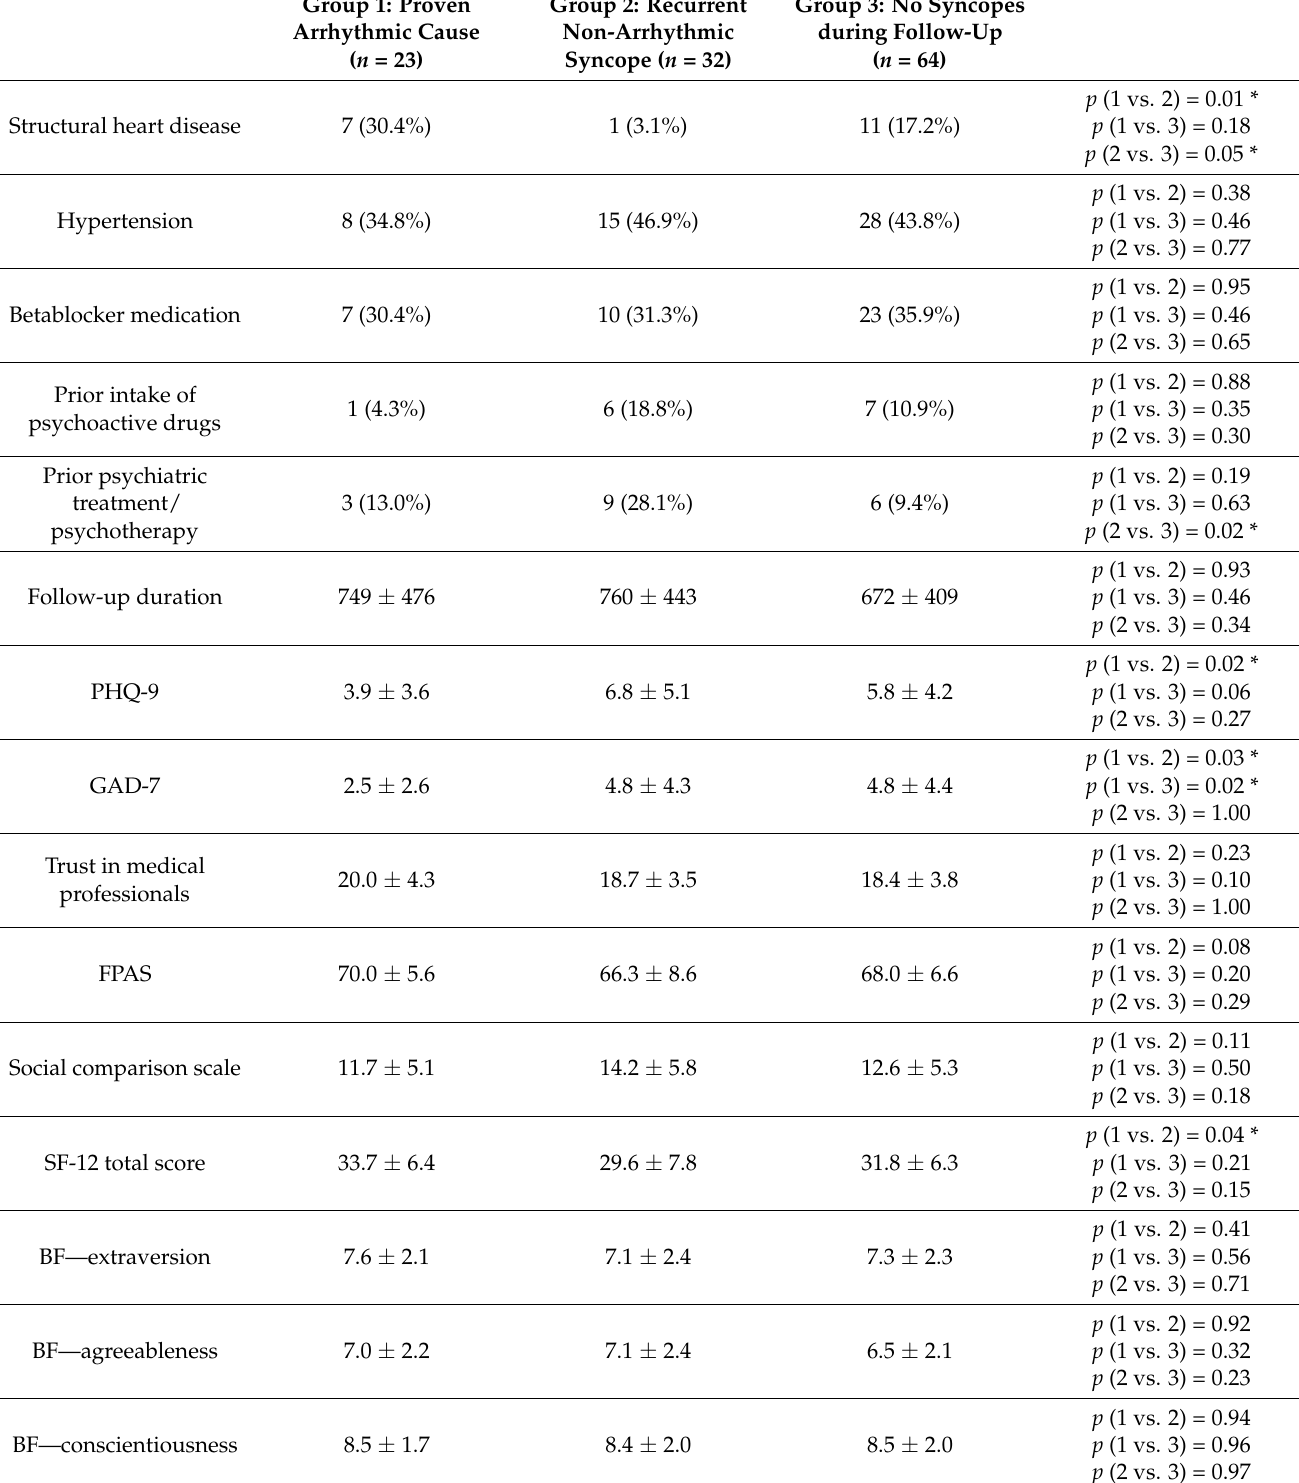
Table 2. Differences between three patient groups as